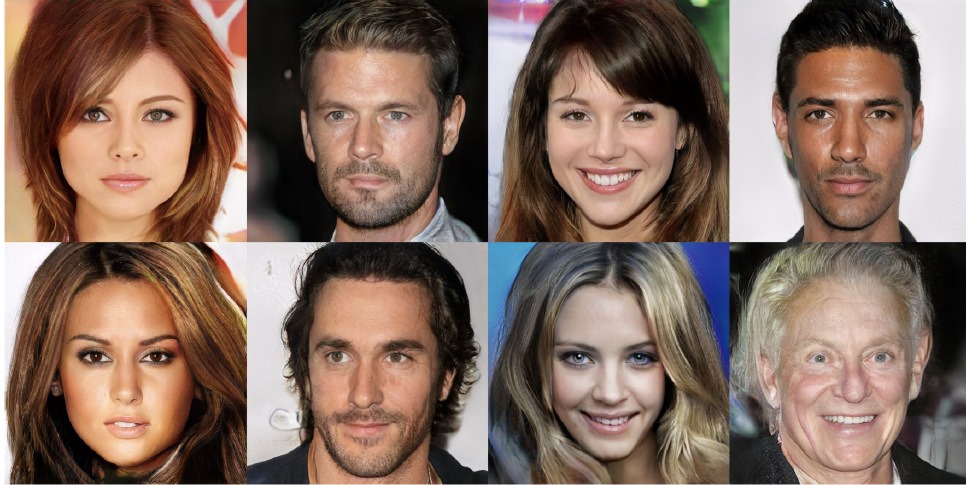
Figure 14. Images generated using ProGAN. Notice the level of detail when compared to the ones generated from AC-GAN (Figure 12). Image taken from [38].